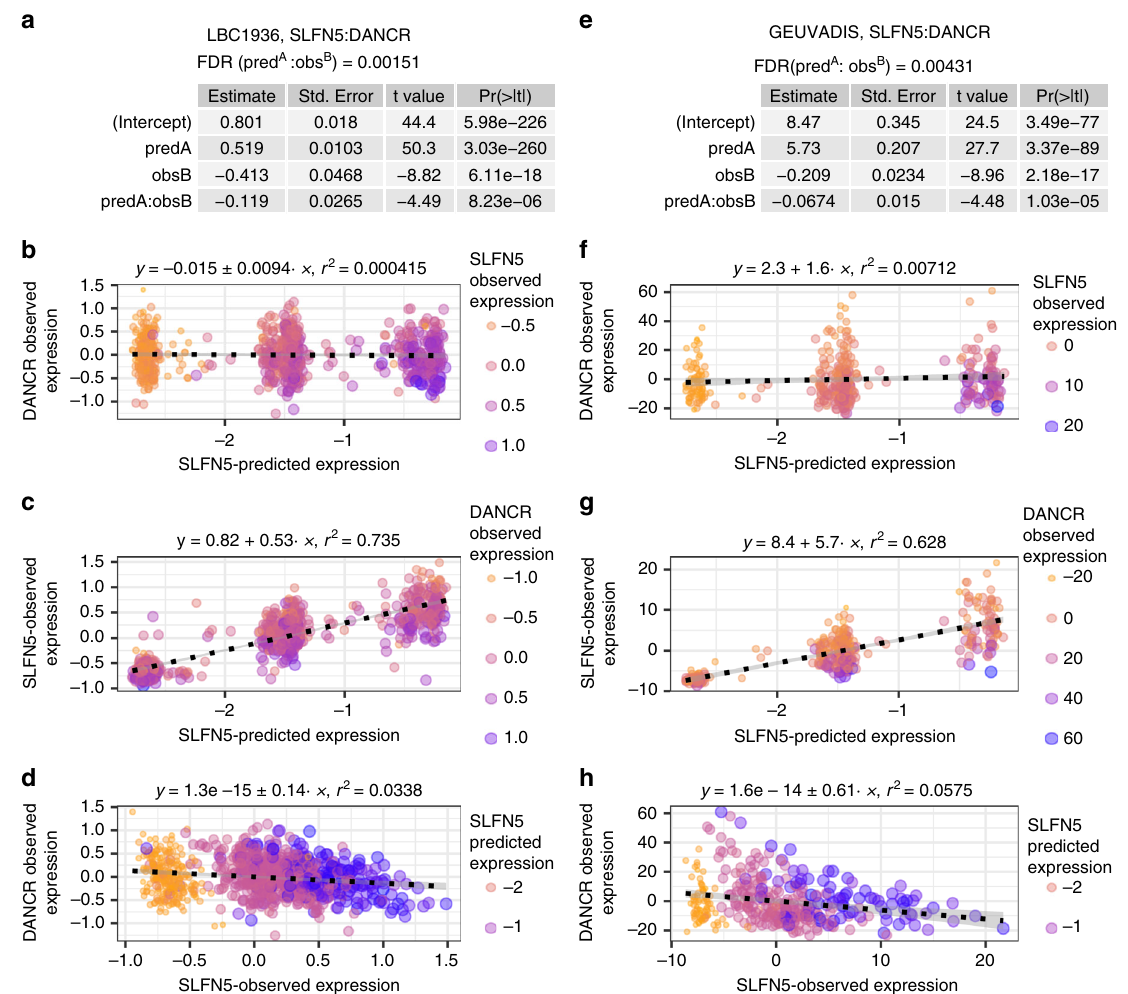
Fig. 5 Signi fi cant regulatory variant-set-dependent interaction between SLFN5 and DANCR . Example of a signi fi cant set-dependent interaction, showing patterns consistent with the simulated data presented in Fig. 3. The expression of SLFN5 is linked to the combination of cis-regulatory variant-set and expression of DANCR . This is shown to be the case for the Lothian Birth Cohort ( a – d ) and is reproduced in the 1000 Genomes data ( e – h ), with both datasets exhibiting statistical signi fi cance (FDR < 0.05) and sign concordance for the interaction term coef fi cient. P and FDR values derived from ANOVA